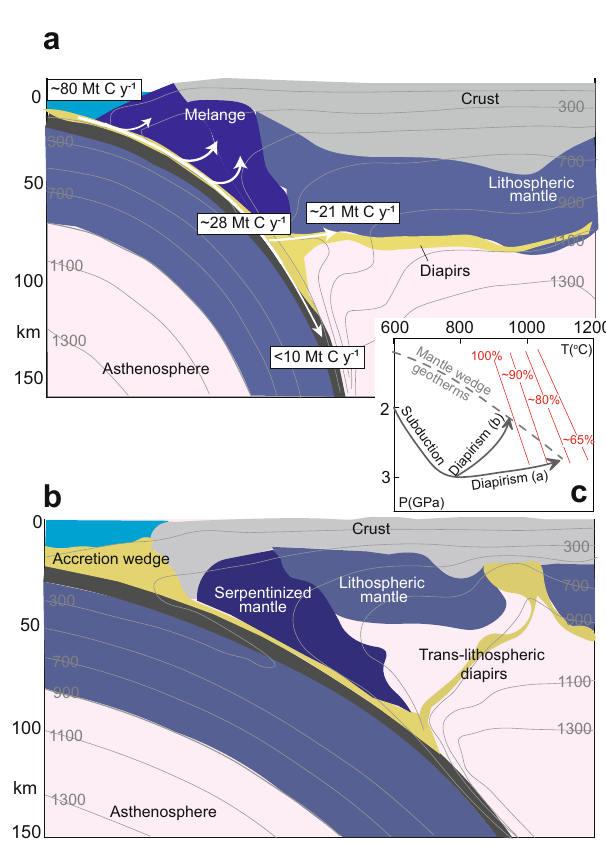
Fig. 6 Carbon fl uxes and reservoirs in convergent margins. Schematic illustration showing two possible scenarios a , b for transfer of limestone- bearing sediments (light yellow) from the slab to the mantle wedge, superimposed on the numerical geodynamic model of Gerya and Meilick 38 at a time shot at >40 Ma from subduction initiation. In the fi rst scenario a there is no extensive melting of the sediments. In the second scenario b , melts derived from the melting of silicate sediments rheologically weaken the lithosphere below the arc forming a weak channel into which sediment diapirs may be emplaced into subarc crust forming trans-lithospheric sedimentary plumes. The carbon fl uxes (white arrows) are similar to Fig. 1a. c The schematic pressure – temperature (P – T) diagram of limestone that is subducted and entrained in a diapir for the two scenarios a and b . The red lines are the proportions of residual calcite during the melting of limestone in contact with the peridotites from the experimental results in